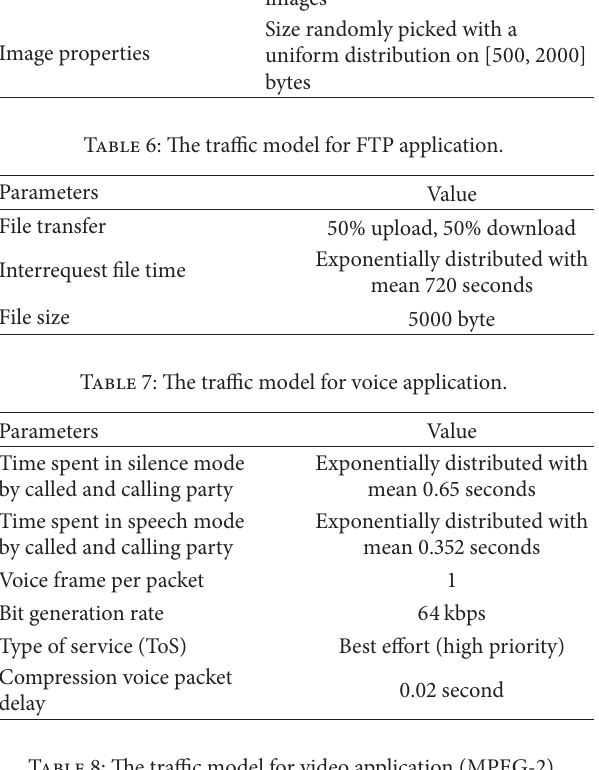
Table 8: The traffic model for video application